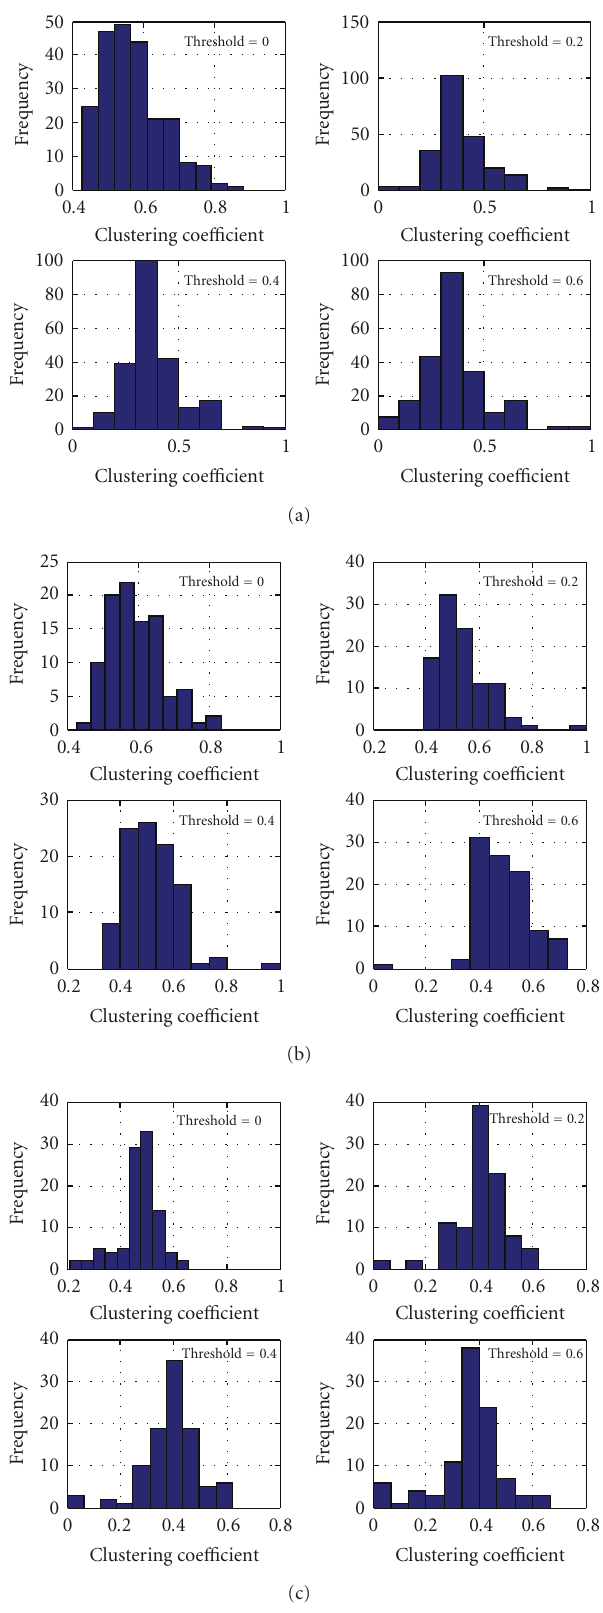
Figure 4: Histogram of clustering coe ffi cients: (a) simulation data; (b) real dataset A; (c) real dataset B.